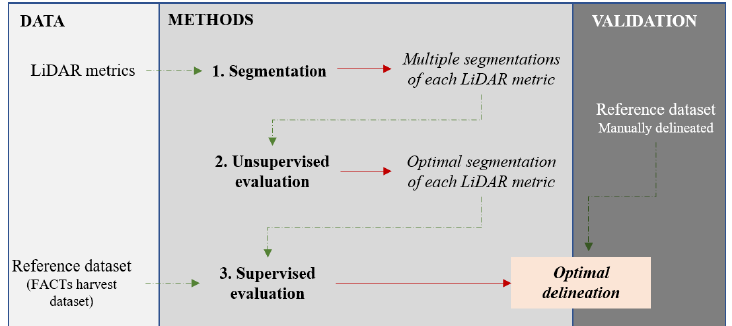
Figure 4. Flowchart of the proposed methodology for forest stand delineation based on a two-stage evaluation strategy.